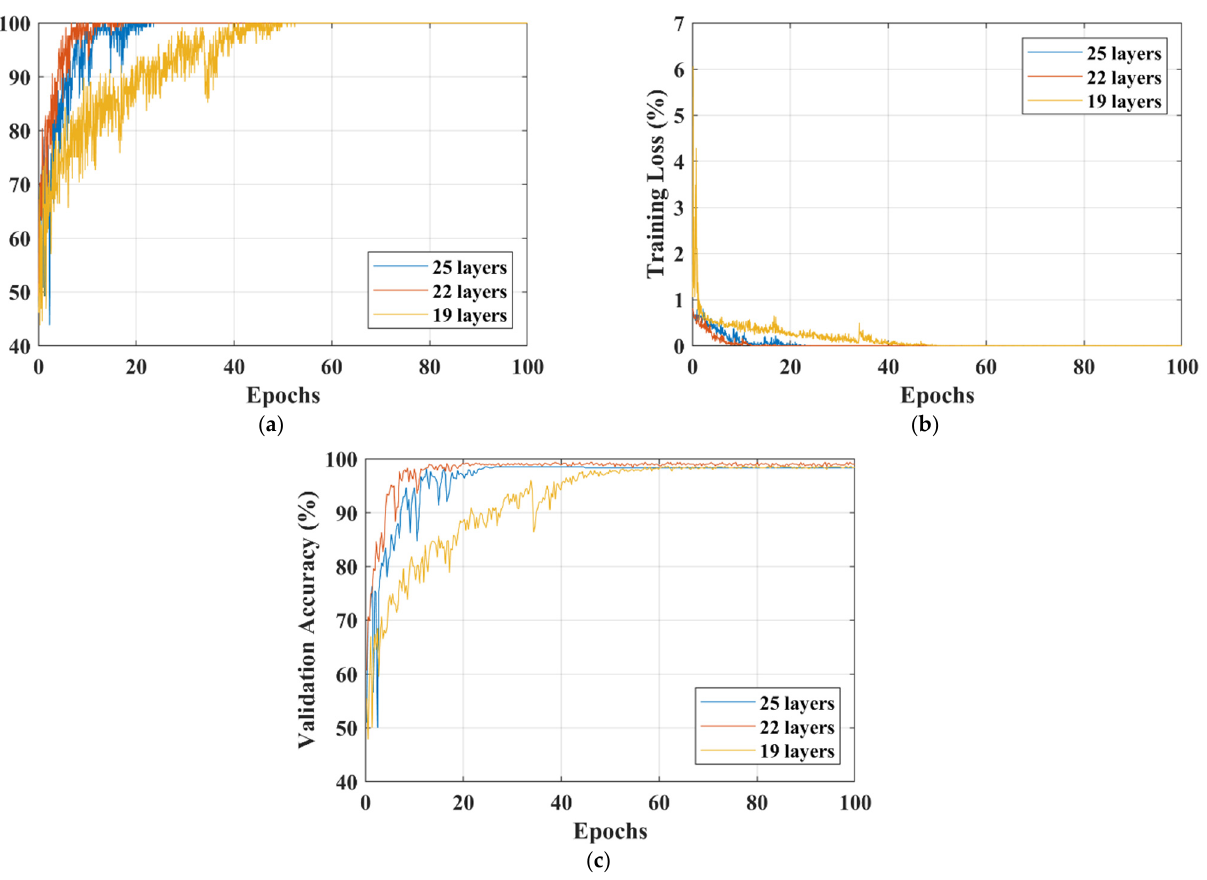
( a ) ( b ) ( c ) Figure 6. Comparison of different isolated-CNN models for dataset-II; ( a ) Training-accuracy curves; ( b ) Training-loss curves; ( c ) Validation-accuracy curves. After deeply analyzing the results of the 19-, 22-, and 25-layer isolated CNNs, it was found that the 22-layer isolated-CNN model had the best classification accuracy for da- taset-I and dataset-II (see Tables 3 and 4). It is also important to note that the 22-layer isolated CNN reached 98% training accuracy in 9 epochs for binary classification, whereas it took only 17 epochs to train the model for dataset-II (see Figures 5 and 6). Figures 5c and 6c also show the isolated-CNN model’s high testing/validation accuracy for datasets-